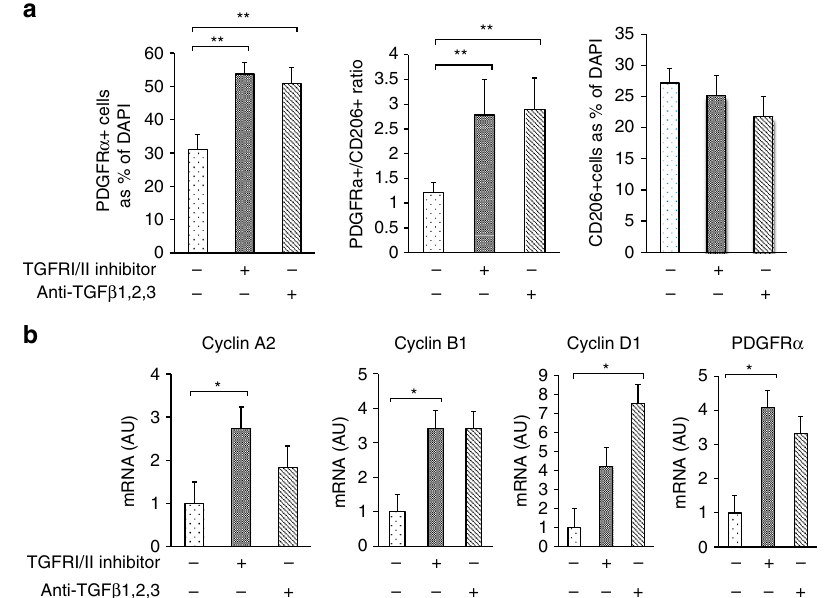
Fig. 6 Reversal of BMDM-induced inhibition of adipogenesis. a Quanti fi cation of PDGFR α and CD206 in in vitro co-cultures of ASC and BMDM after the addition of a TGF β RI/II inhibitor (LY2109761) and anti- TGF β 1,2,3 antibody to the medium for 48 h. The PDGFR α and CD206 + macrophages were both counted as the percentages of DAPI-positive cells. b The relative mRNA expression levels of cell proliferation-related genes and PDGFR α . The data were calculated from experiments of 3 – 6 dishes per group. The data are shown as the means ± SEM. * P < 0.05, ** P < 0.01 compared with control by